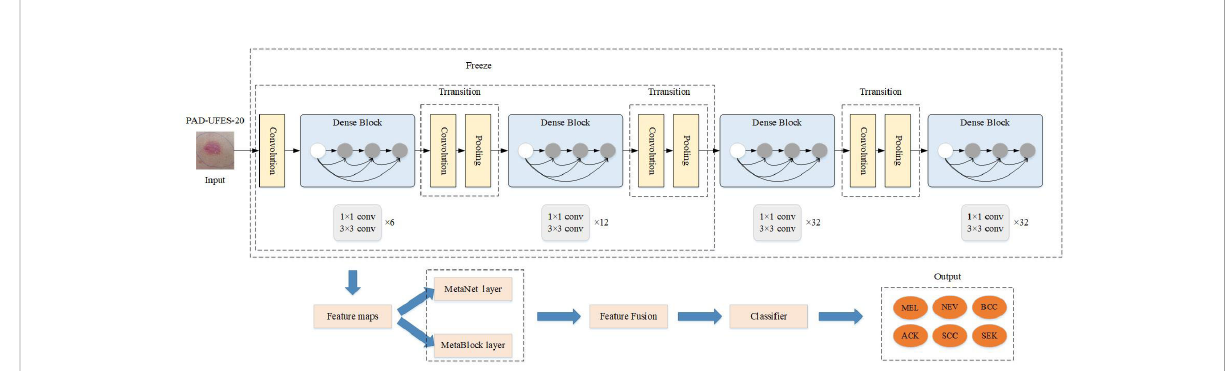
FIGURE 1 Design diagram of the improved Denset-169 network structure. The features extracted from MetaNet and MetaBlock modules are fused to construct the MD-Net module.